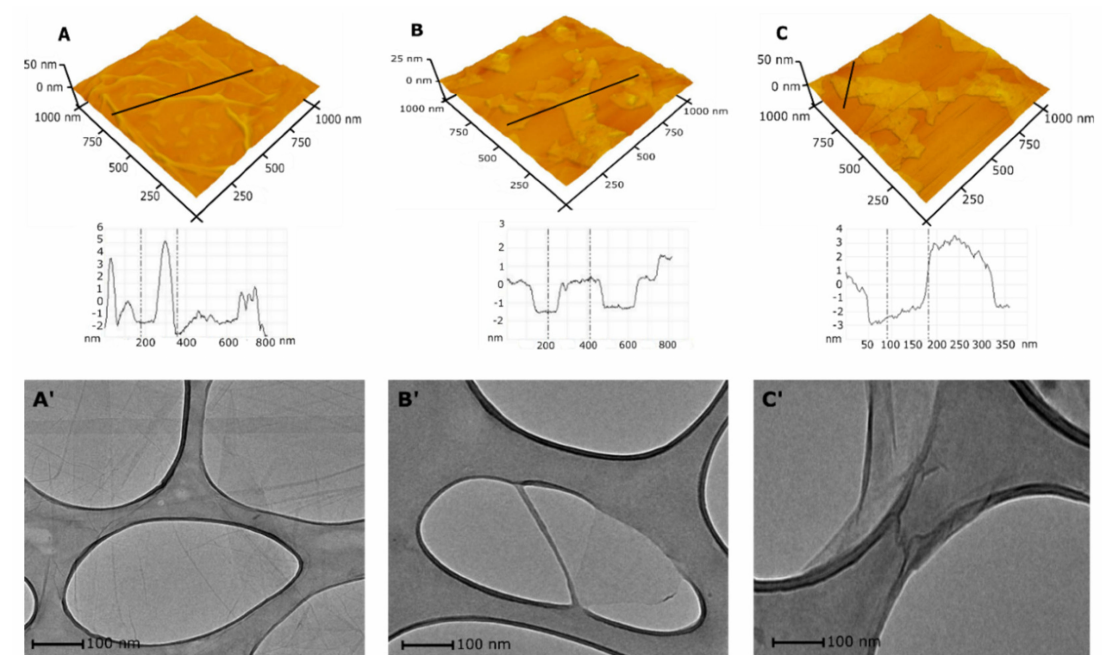
Figure 4. The results from microscopic analyses indicating morphological changes during the sonication process. Upper panel: 3D atomic force microscopy (AFM) images of pristine GO, ( A ) 2n-GO (after 2 h sonication), ( B ) and 3n-GO ( C ). The graphs in the middle show the corresponding cross sections. The bottom panel: high-resolution transmission electron microscopy (HRTEM) images of pristine GO material ( A’ ), 2n-GO ( B’ ), and 3n-GO ( C’